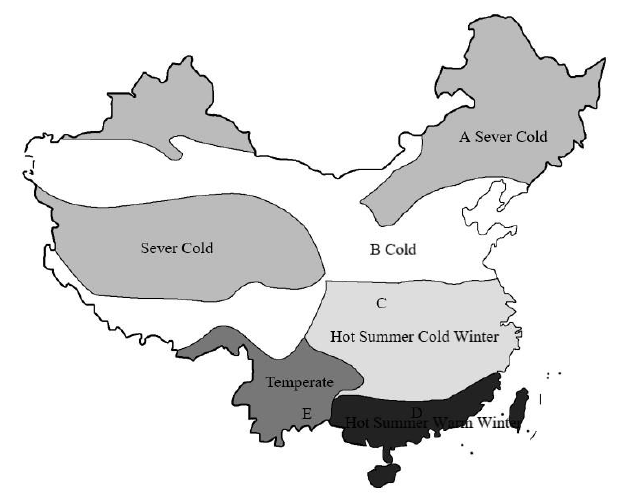
Figure 1. Five climates in China.